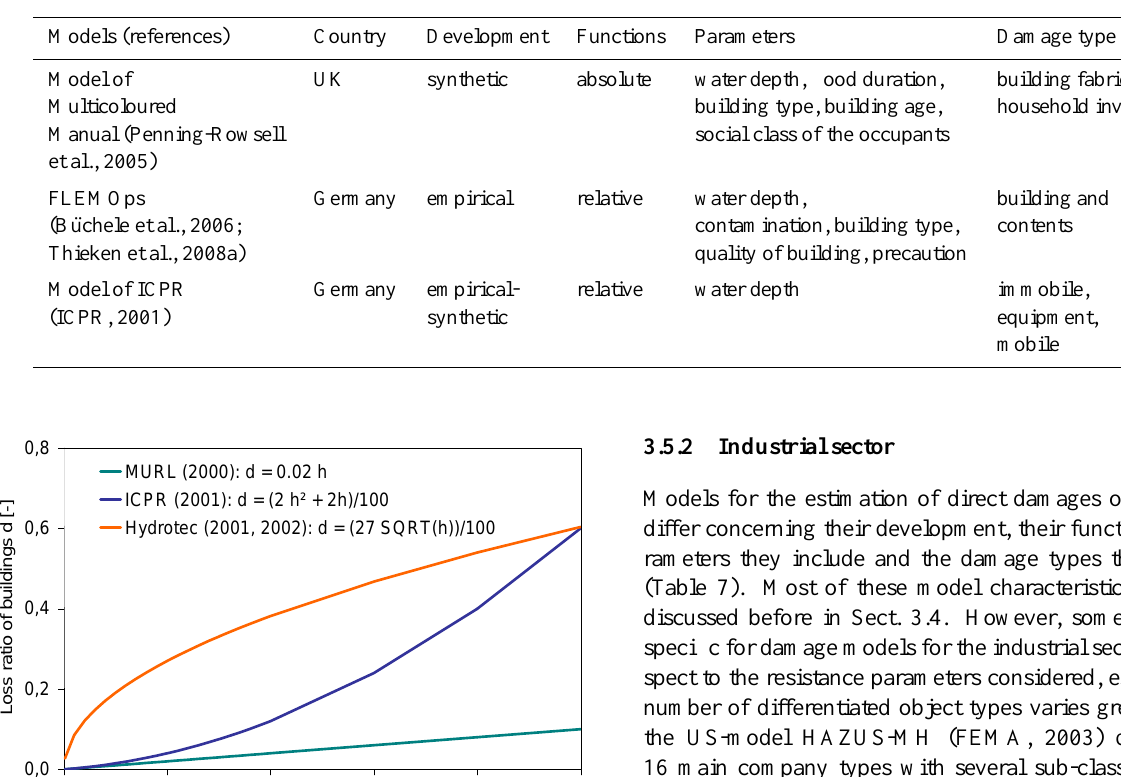
Table 6. Comparison of three exemplary damage models for the residential sector.